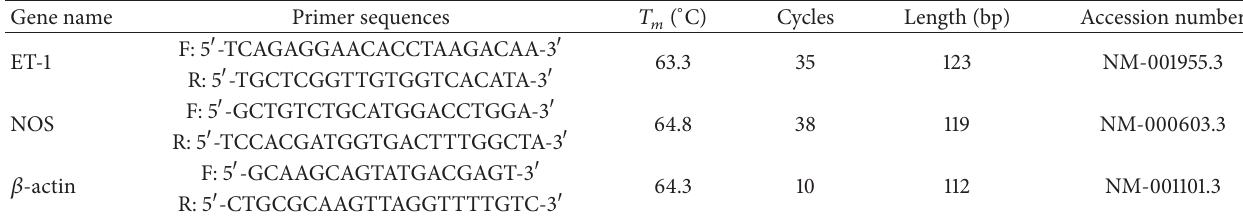
Figure 4: Effect of EM1, EM2 on iNOS level in HUVEC. Each data is expressed as mean ± SD ( 𝑛 = 3 ). ∗ 𝑃 < 0.05, ∗∗ 𝑃 < 0.005 versus AGEs-BSA group, # 𝑃 < 0.05, ## 𝑃 < 0.005 versus control (BSA) group. Table 1: Primers used for